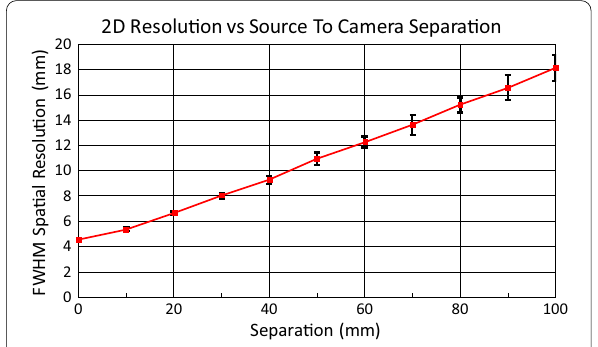
Fig. 5. 2D spatial resolution of NaI(Tl)–SiPM gamma camera. Error bars indicate the 95% confidence intervals derived from six trials. The image pixel size is 2.5